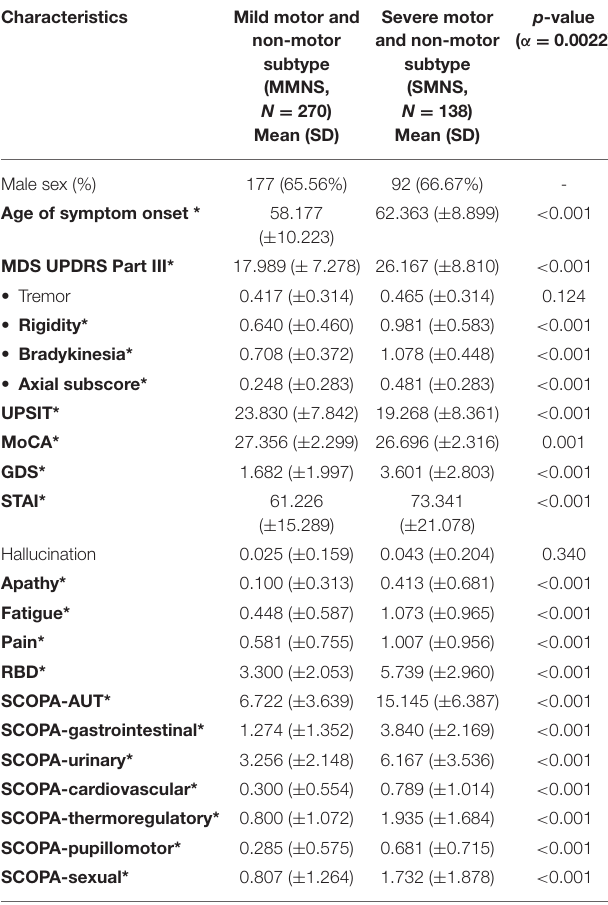
TABLE 1 | Baseline clinical characteristics of PD subtypes.